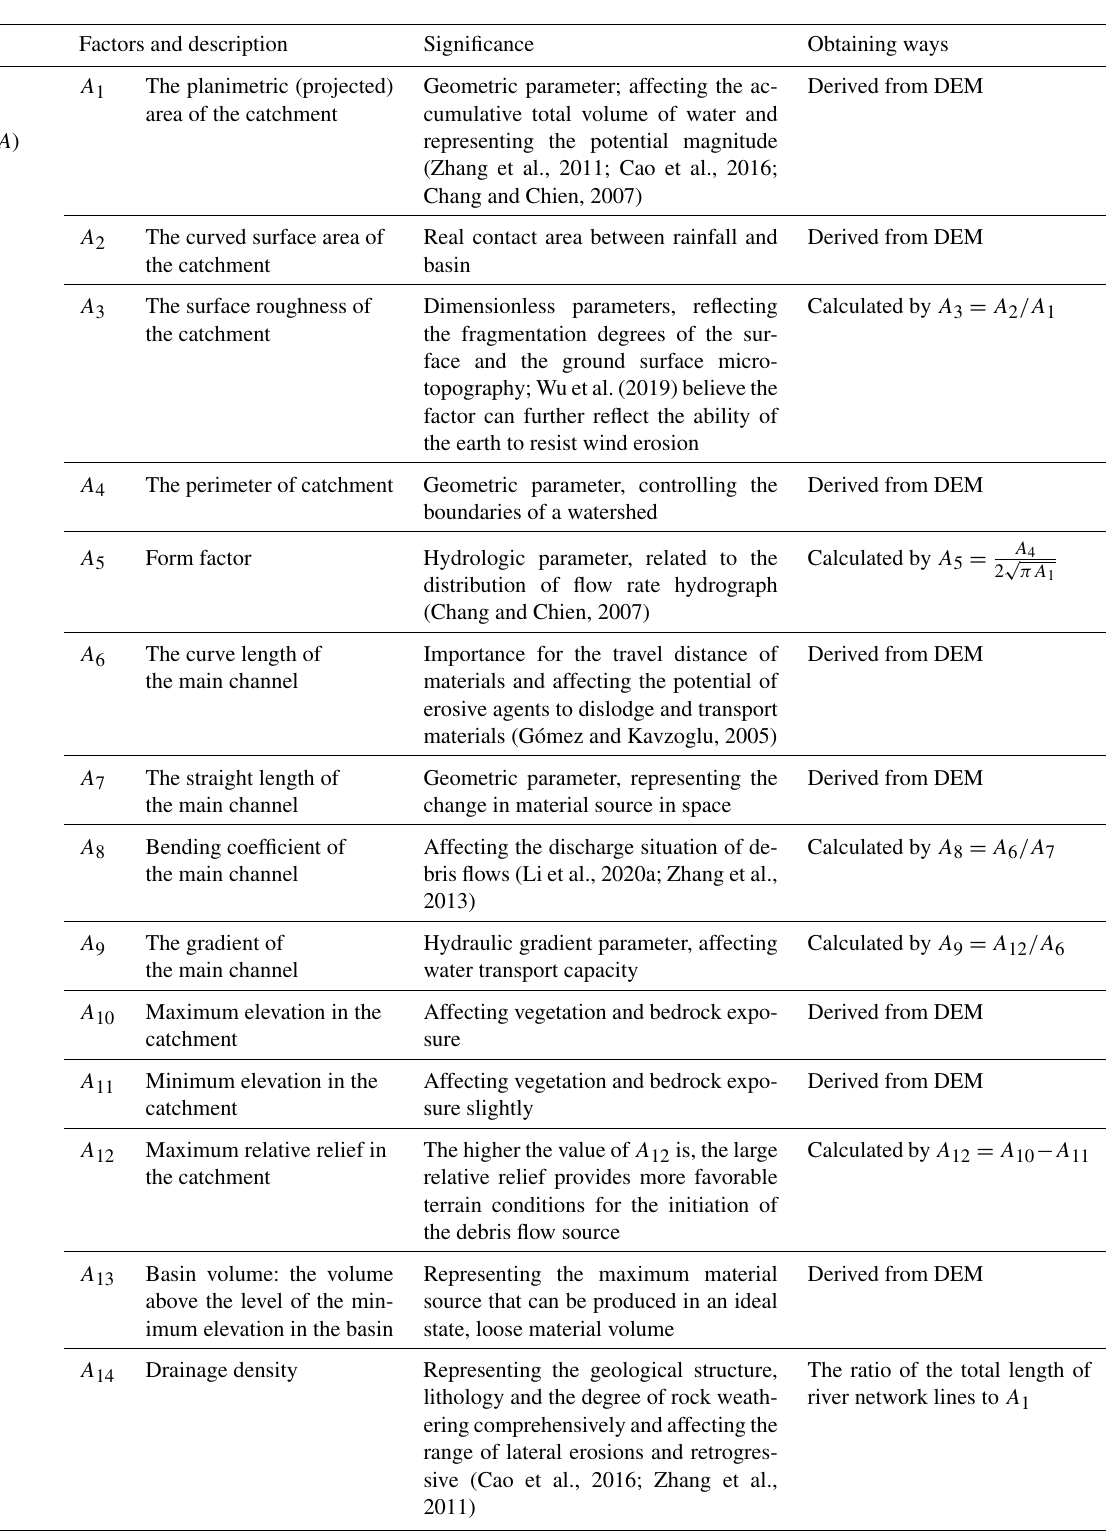
Table 1. Factors for susceptibility